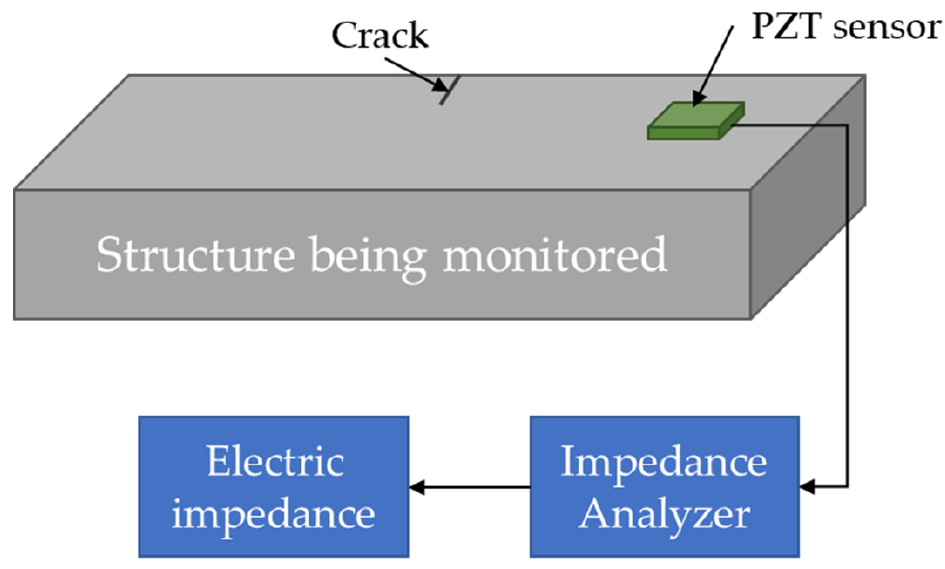
Figure 6. SHM of the cracked structure by impedance analyzer. Sensor amplifiers and data acquisition units make up passive diagnostic hardware. Through a sensor network, the impact monitoring system collects stress wave signals produced by impact loads [120]. Figure 7 illustrates the process of the impact monitoring of aircraft